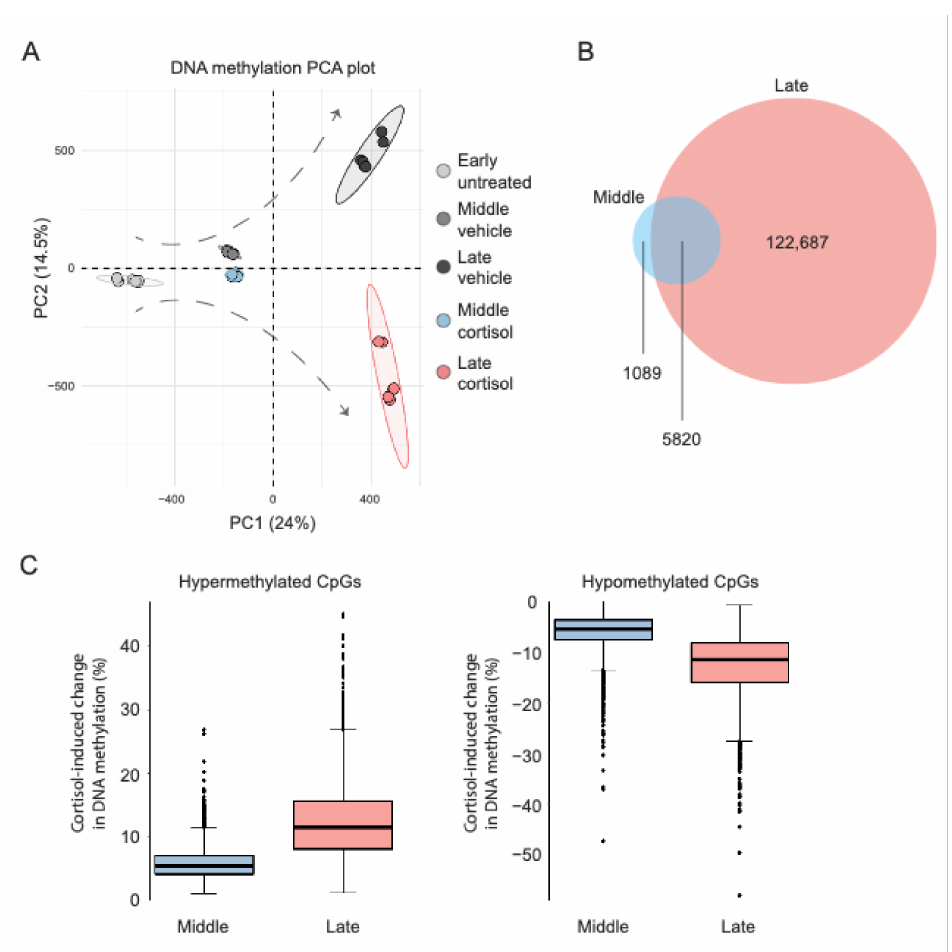
Figure 1. Prolonged cortisol exposure induces widespread and cumulative DNA methylation changes. ( A ). Principal component analysis (PCA) of Illumina EPIC array data showing the progression of cortisol-induced methylomic changes along the cellular lifespan. ( B ). Venn diagram depicting the number of CpG sites with significant treatment condition-duration interaction and methylation differences between cortisol and vehicle groups at middle or late passage. ( C ). Boxplots comparing the magnitude of cortisol-induced methylation changes (hyper- or hypo-methylation) at middle and late passage. Each datapoint represents a significantly changing CpG and methylation